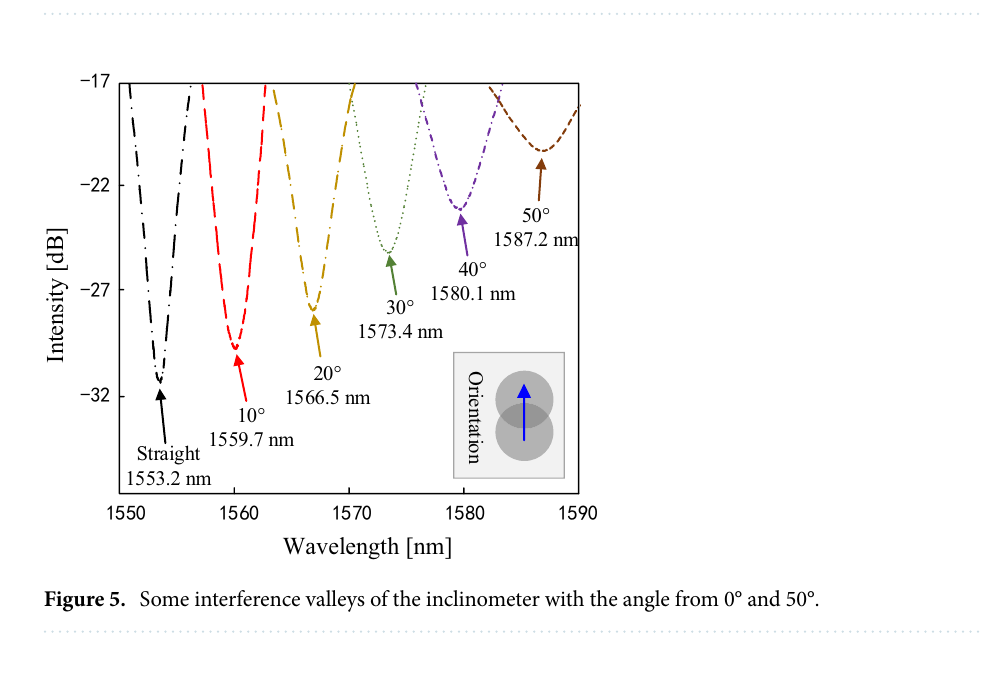
Figure 4. Interference spectrum of the sensor with misalignment-spliced fiber length of 2 cm and core offset of 8 μm.